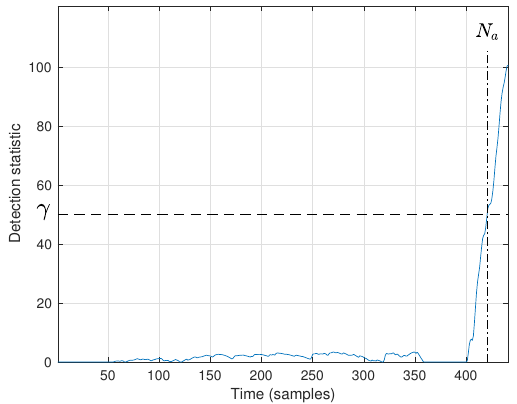
Figure 4. Decision